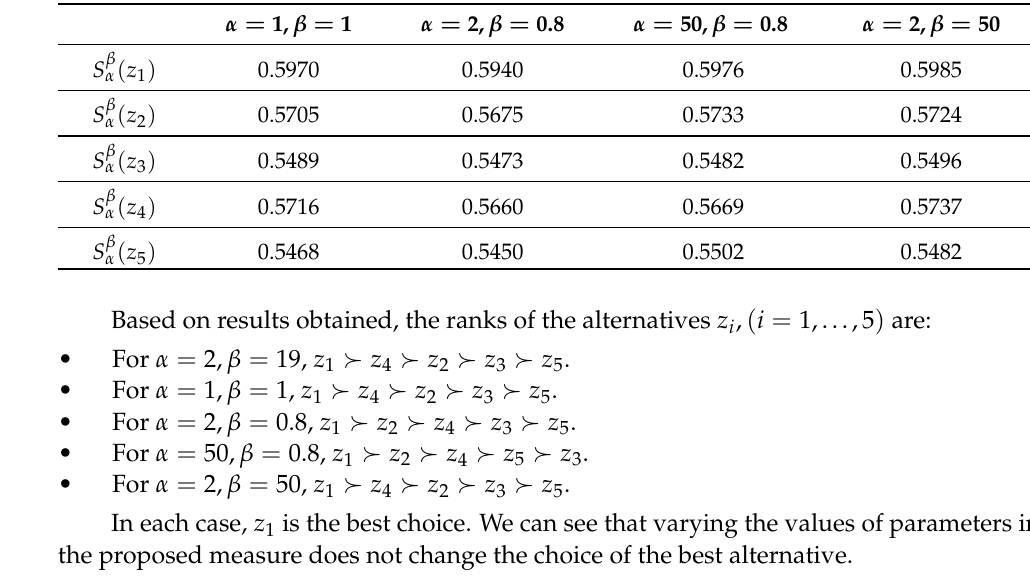
Table 3. Values of S β α ( Z ) and β α υ for different α , and β . α = 1, β = 1 α = 2, β =